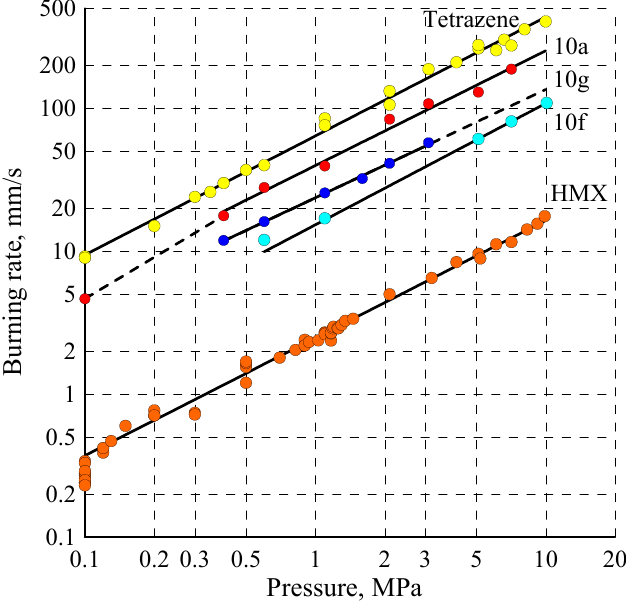
Figure 8. Comparison of burning rates at different pressures for 10a , 10f , and 10g with tetrazene and HMX. Dotted line is extrapolation.